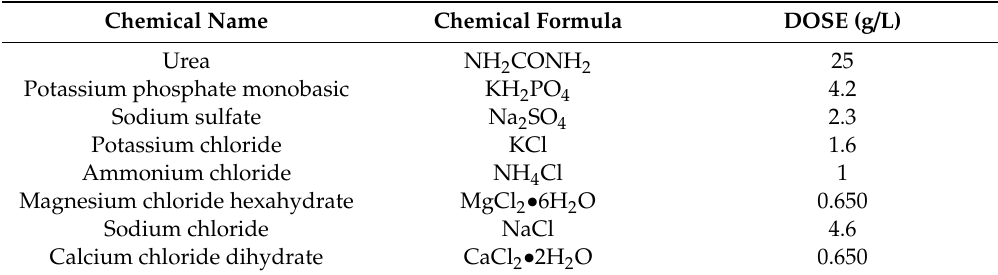
Table 1. Chemical composition of synthetic urine without other organic